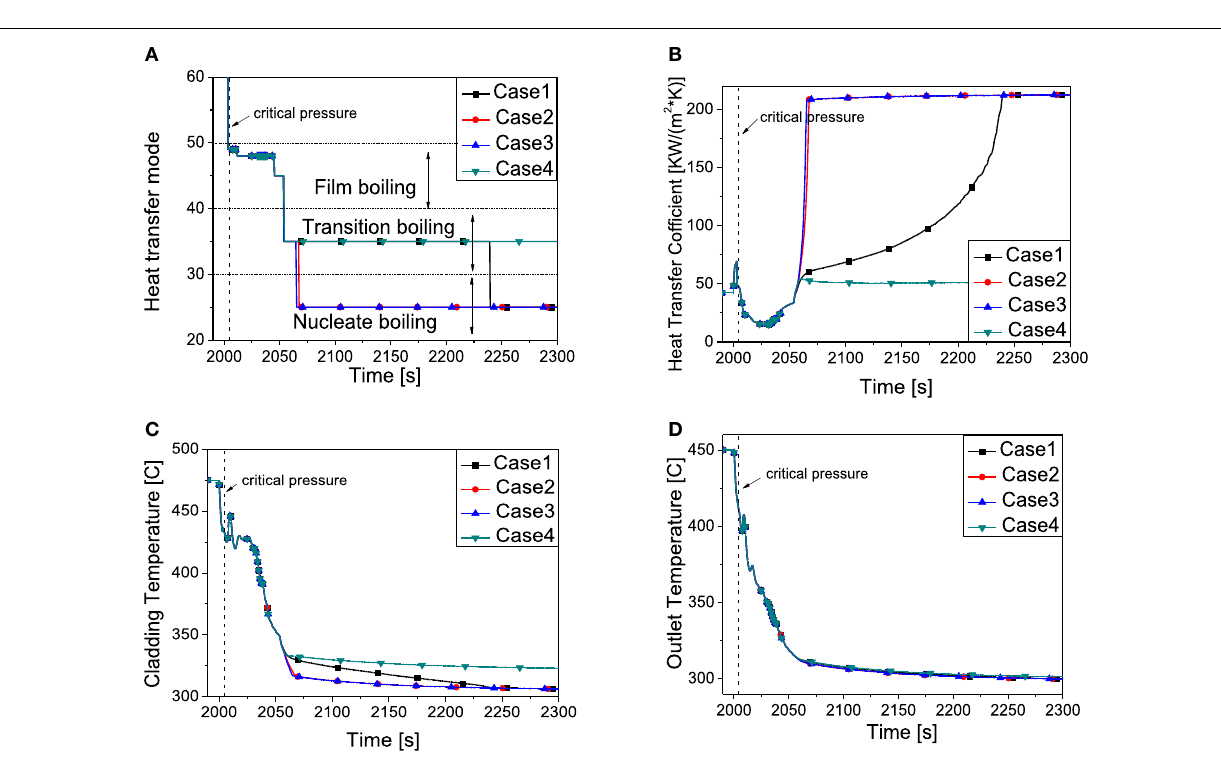
FIGURE 14 | System behavior by the effect of correlations for CHF . (A) Heat transfer mode. (B) Heat transfer coefficient. (C) Peaking cladding temperature. (D) Core outlet temperature.